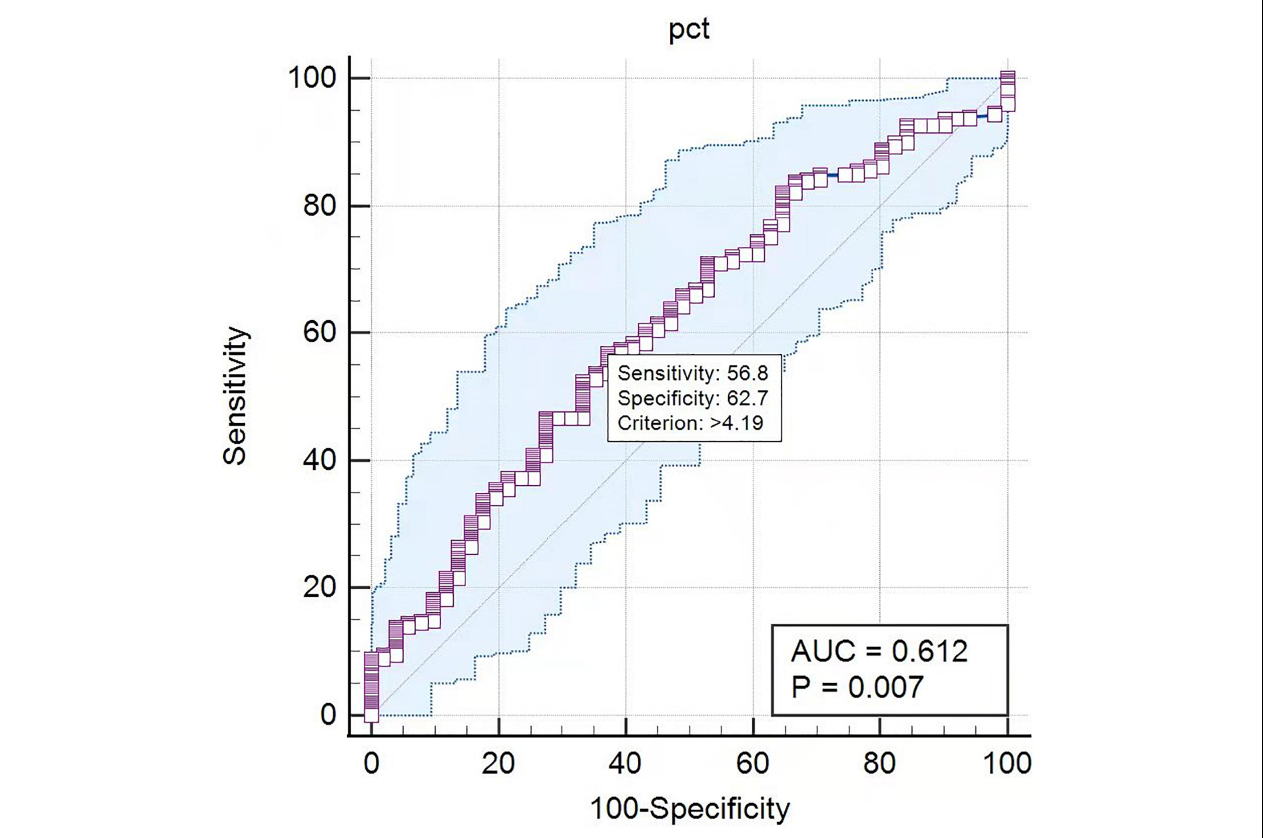
FIGURE 3 | The ROC curves of PCT predicting bacteremia from fungemia. PCT: AUC = 0.612, cutoff point 4.19 ng/mL, sensitivity 56.8%, specificity 62.7%.